Question: Summarize what this figure shows in one sentence.
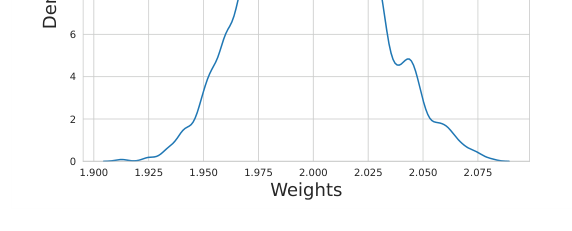
Answer: Weight distribution of NLI4CT data instances generated by the auxiliary model after 3 epochs of train- ing. Lower weights correspond to easy examples, and higher weights correspond to hard examples.